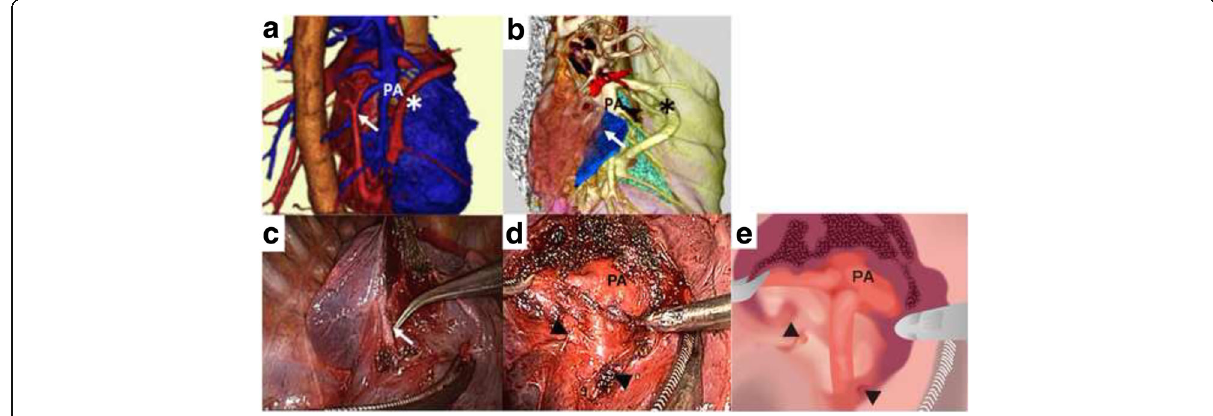
Fig. 2 Preoperative 3D images and corresponding intraoperative findings. a Three-dimensional image shows an abnormal vein ( arrow ) running over a branch of the pulmonary artery. b An overlay of each lobe (shown in different colors ) and a relatively well-developed fissure (marked blue ), which is similar to that between the superior and basal segments of the lower lobe. The interlobar vascular structures seemed easiest to approach from this fissure ( arrow ). c Corresponding intraoperative view shows the exposed abnormal pulmonary vein ( arrow ; same vein as shown in a ). d After transecting the abnormal vein shown in ( c ) ( arrowheads ), the interlobar pulmonary artery behind was approached according to the 3D images. e A traced illustration of ( d ). Asterisks in ( a ) and ( b ) indicate the same arch of an abnormal pulmonary